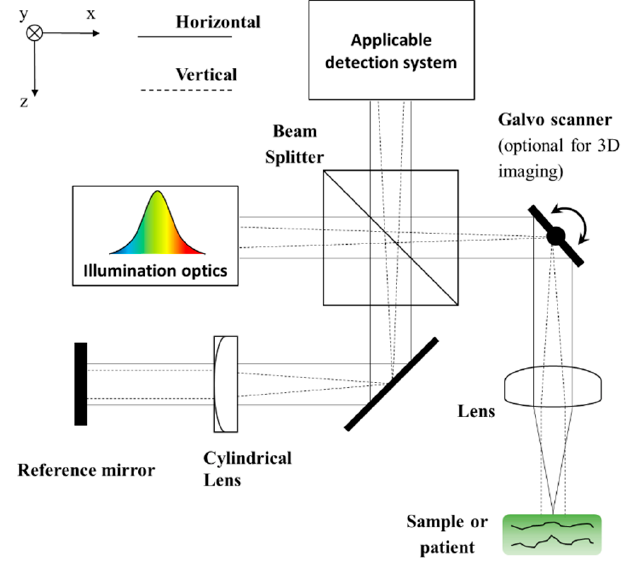
Figure 3. Generic reference recollimation setup. The cylindrical lens acts to recollimate the reference path light coming out of the illumination optics.